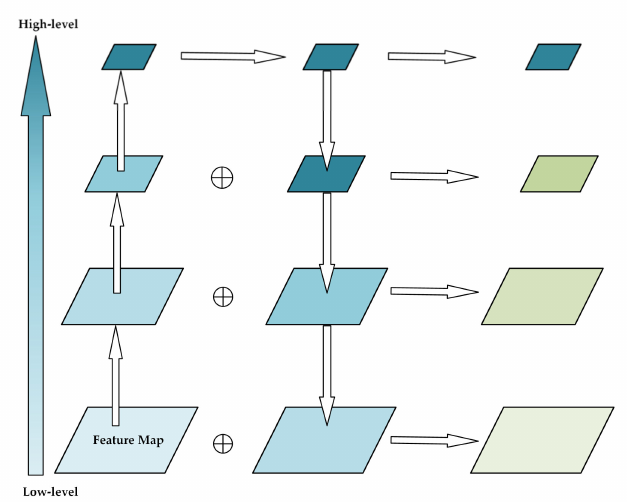
Figure 3. The schematic diagram of the semantic interpolation processing, where ⊕ represents the element-wise sum